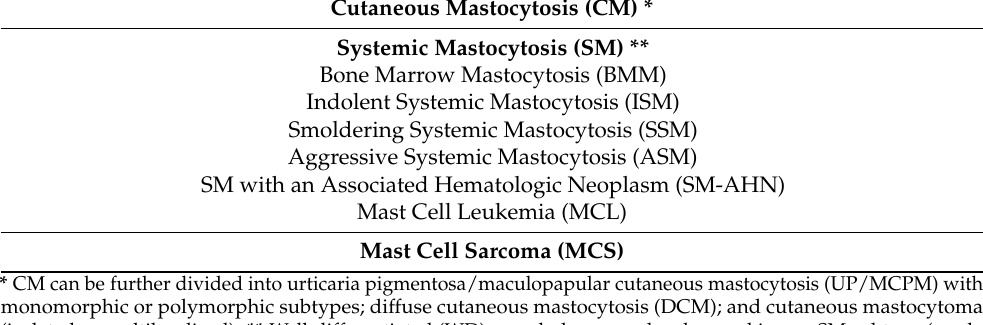
Table 1. 2022 WHO classification of mastocytosis